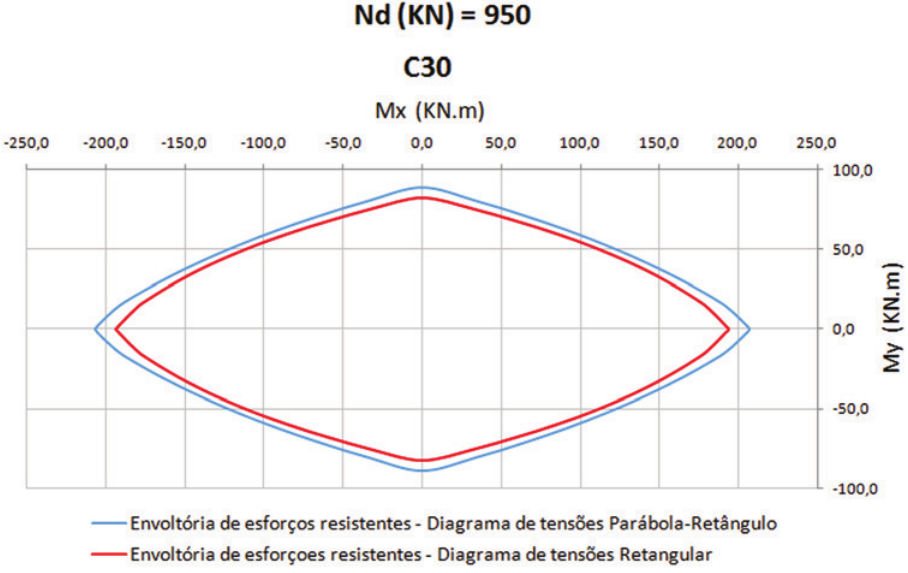
Exemplo de sobreposição de envoltórias resistentes